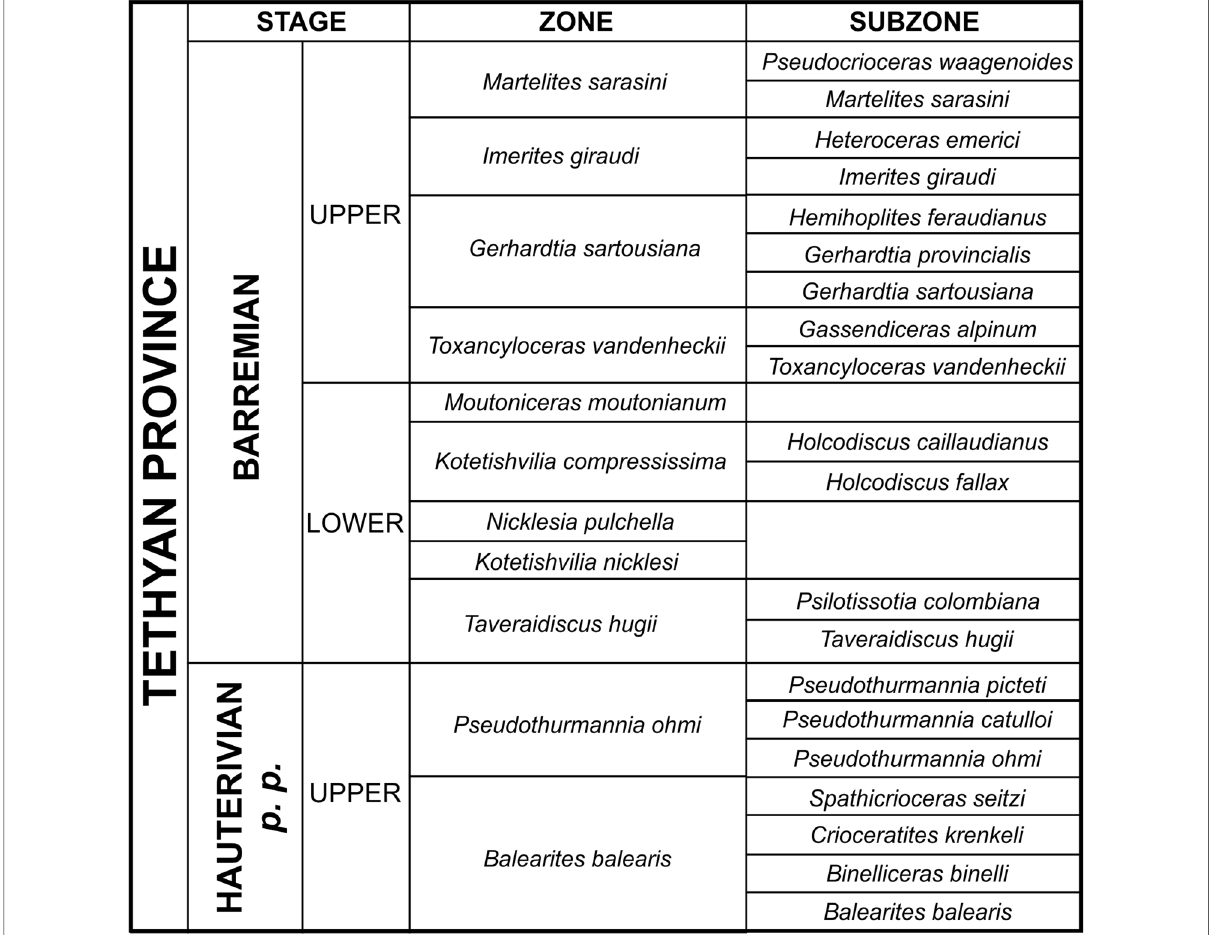
Fig. 2 The standard Mediterranean ammonite zonation of the upper Hauterivian pro parte and of the Barremian stages (Reboulet et al.,